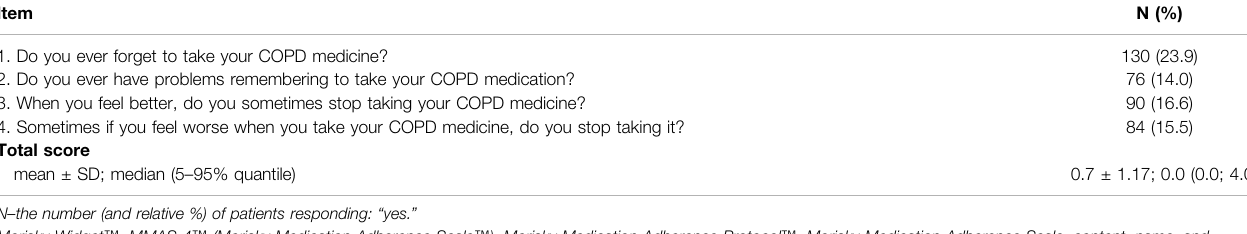
TABLE 1 | Overall adherence based on Morisky Medication Adherence Scale (©MMAS-4). Item N (%)